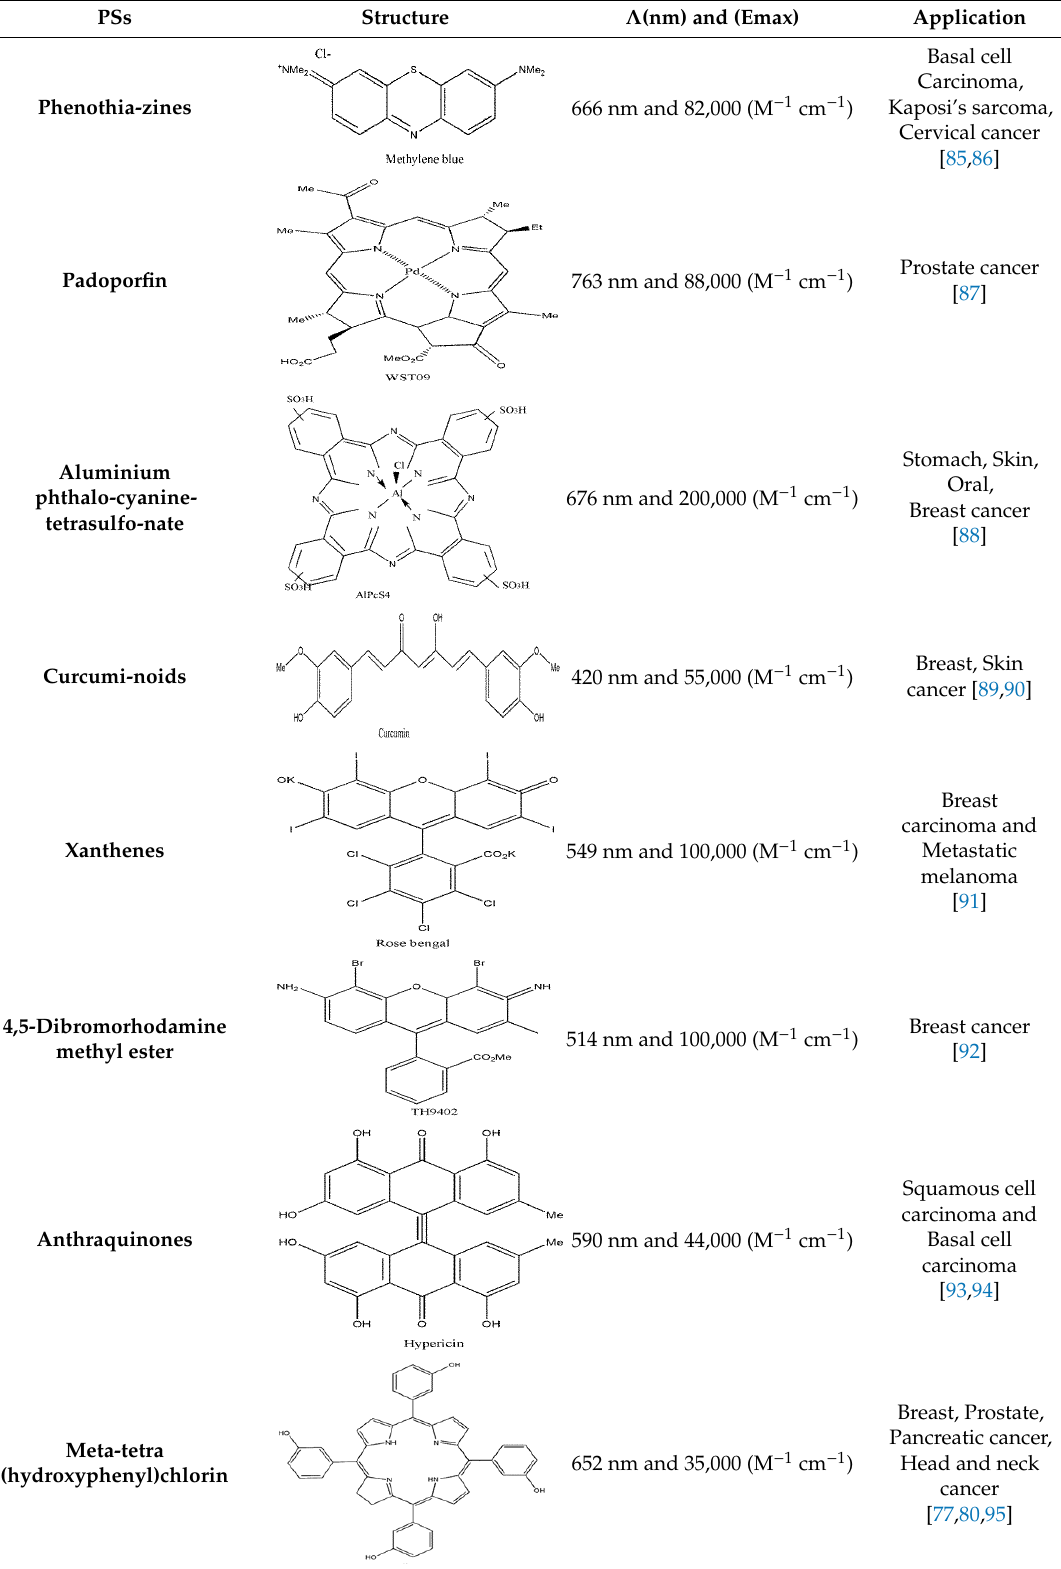
Figure 2. Examples of porphyrinoids: Porphyrin, Chlorin, Porphycene, Bacteriochlorin, Phthalocyanine, Texaphyrin. Figure 3. Examples of nonporphyrin: Anthraquinones, Xanthenes, Phenothiazines.